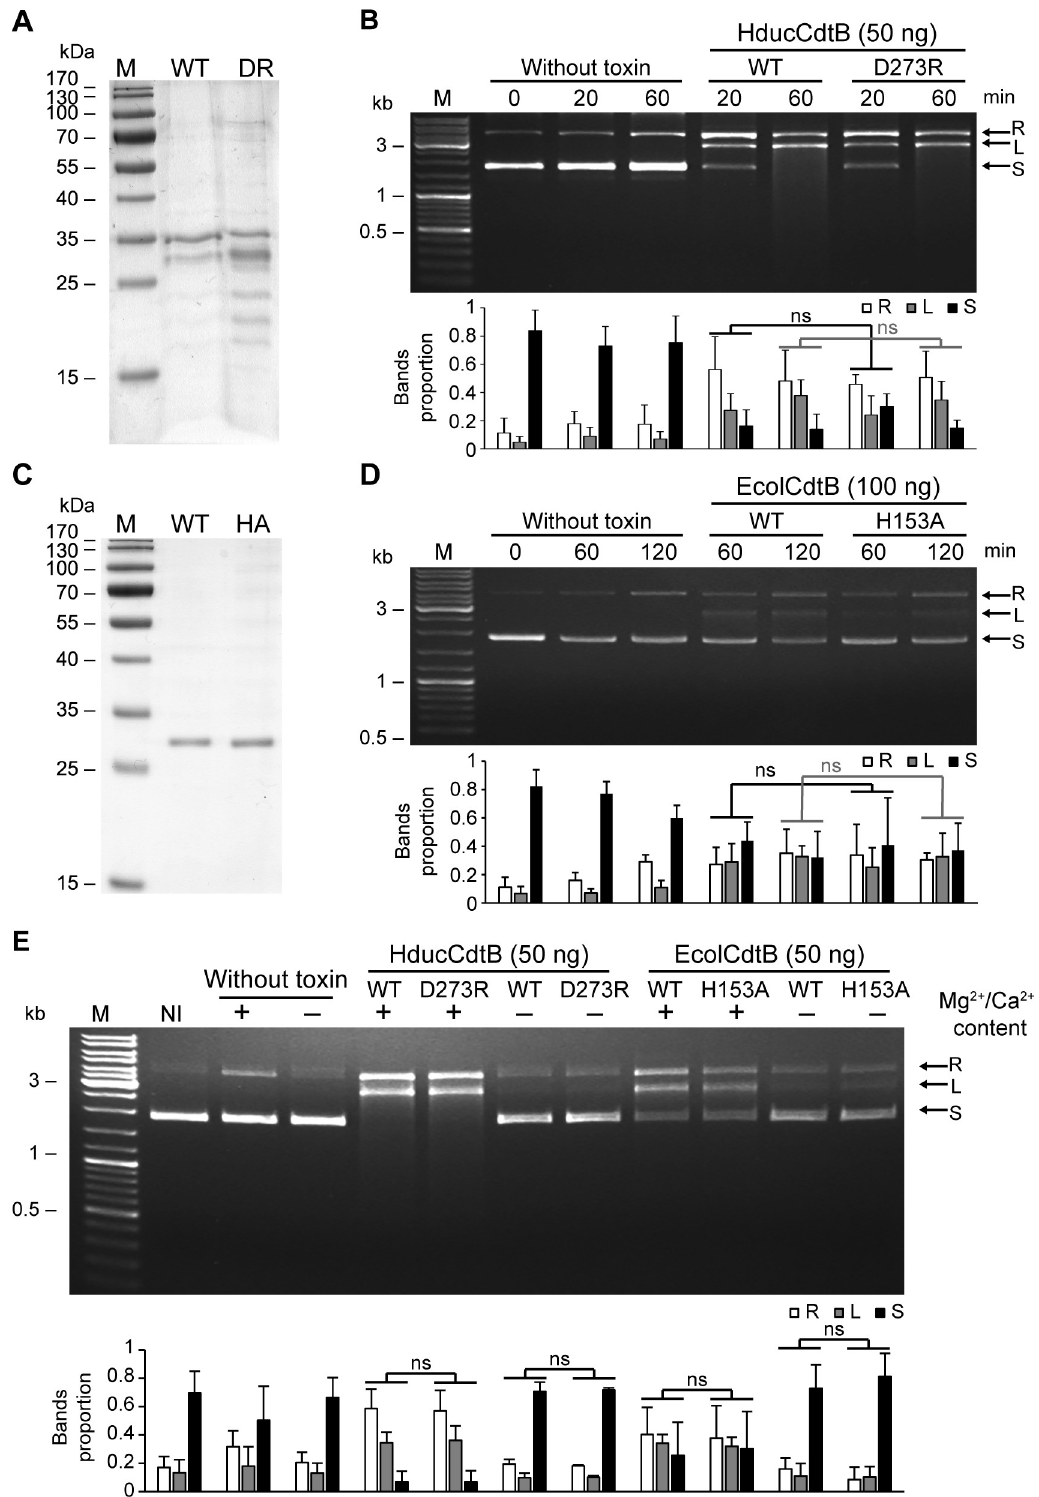
Fig 2. Wild-type or catalytic mutant of EcolCdtB and HducCdtB purified under native condition present a similar plasmid digestion activity. A. SDS-PAGE analysis of WT and D273R (DR) HducCdtB proteins purified from E . coli NiCo21 (DE3) under native conditions. M: molecular weight marker. B. Kinetics of the plasmid digestion assay in presence of WT or D273R